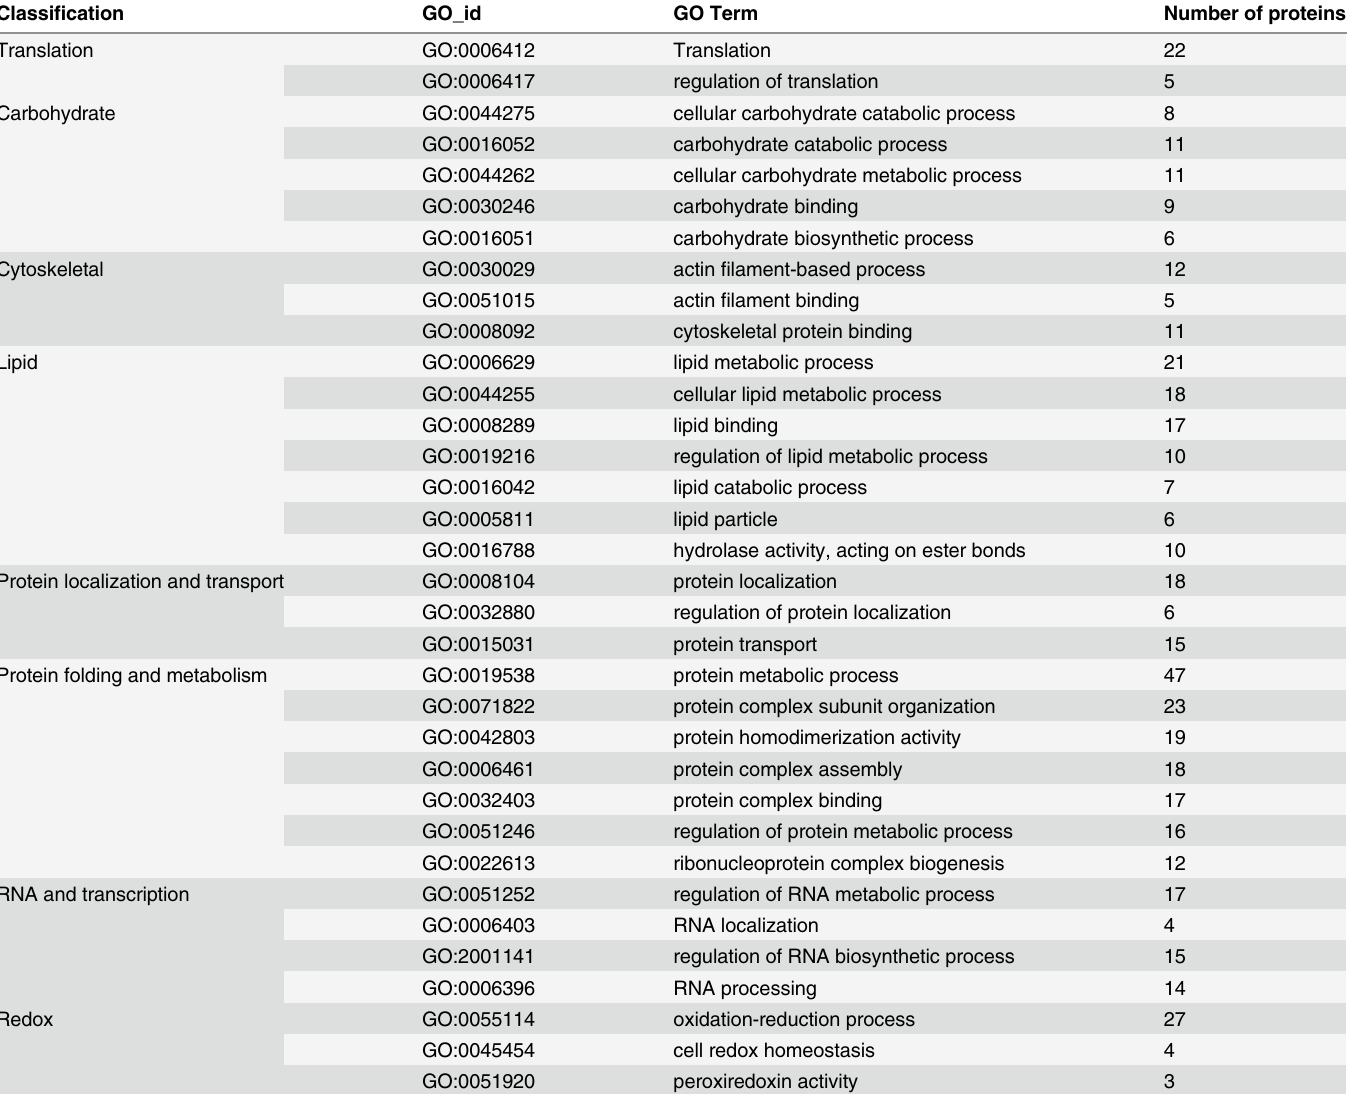
Table 1. GO Terms associated with protein classification term.